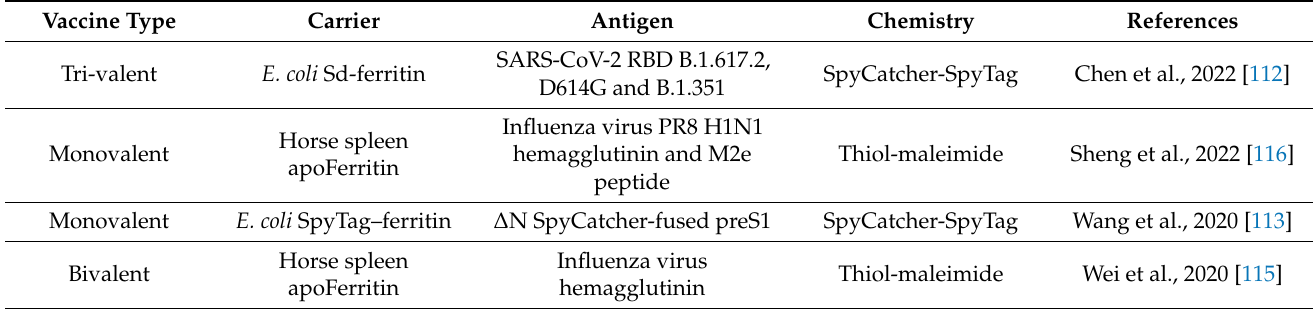
Table 5. Protein nanocages conjugation strategies.